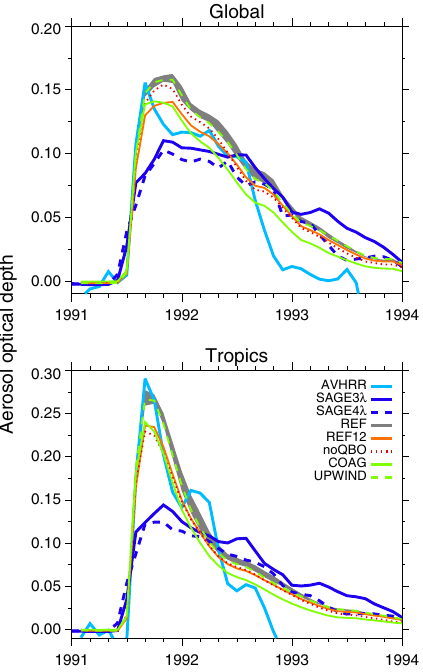
Figure 5. Same as in Fig. 4 but averaged over non-masked re- gions globally (80 ◦ S–80 ◦ N) and in the tropics (20 ◦ S–20 ◦ N). Grey shaded area: 2 σ ensemble spread of the REF experiment. All other experiments are shown as ensemble